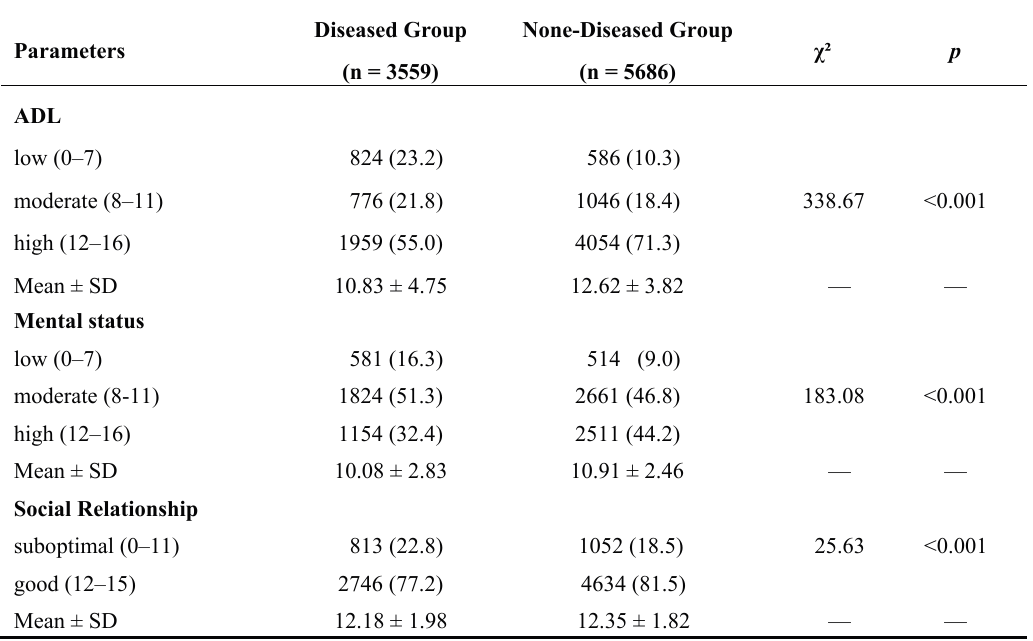
Table 4. Scores of ADL, mental status and social relationship among the rural elderly people, ( n = number, %)